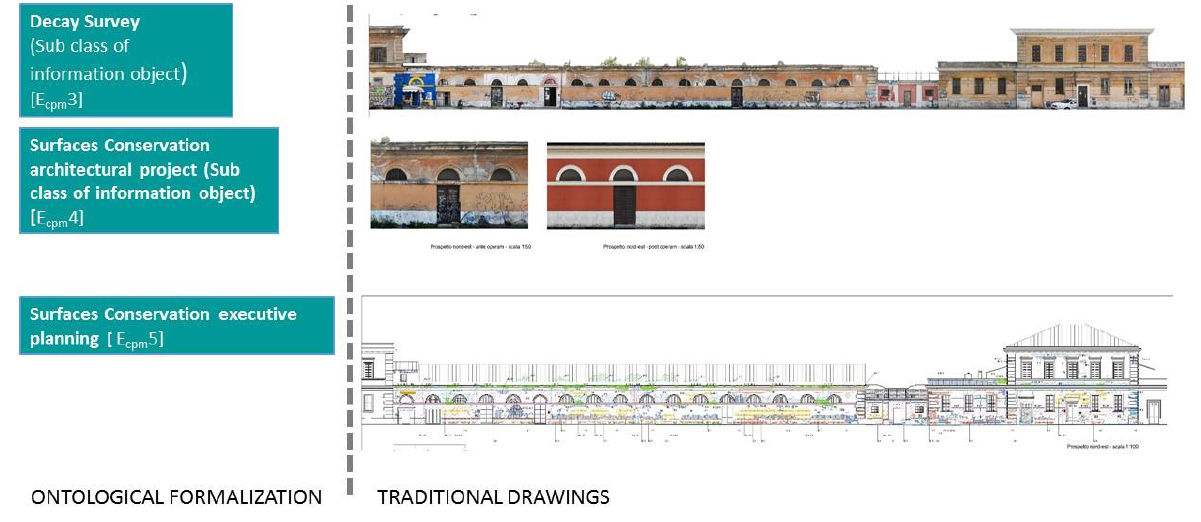
Figure 5. Comparison between model classes and traditional representation of the surfaces conservation project.